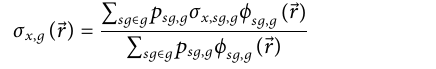
Geometry of thermal spectrum problem.